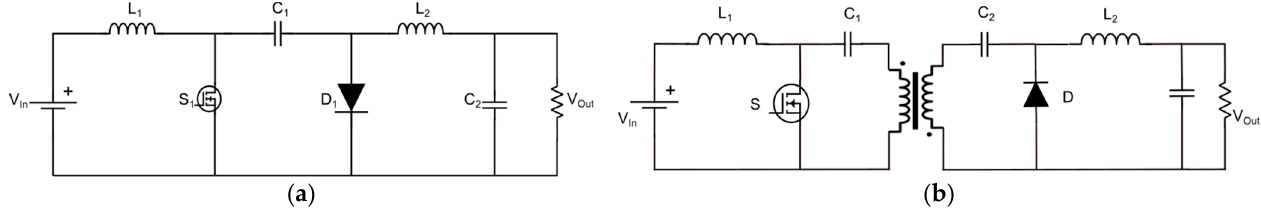
Figure 4. Ć uk converter ( a ). Isolated Ć uk converter ( b ). Figure 4. ´Cuk converter ( a ). Isolated ´Cuk converter ( b